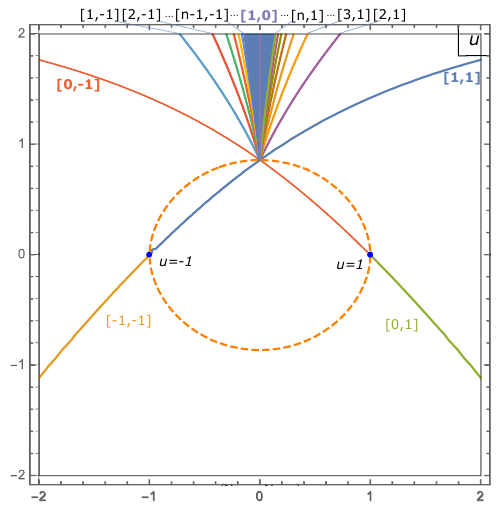
Figure 15 . The u plane for the pure SU(2) SYM theory with Λ = 1 . The wall of marginal stability is shown as an orange dashed curve passing through the magnetic and dyonic singularities at u = ± 1 . We plot arg( Z ( u, Λ = 1)) = π/ 4 for different γ . The notation [ i, j ] stands for a γ path obeying arg( Z ( u, Λ = 1)) = π/ 4 . In the strong coupling region we have only two paths γ [ i,j ] corresponding to arg( Z ( u, Λ = 1)) = π/ 4 and arg( Z ( u, Λ = 1)) = π/ 4 . Outside the wall of γ [0 , − 1] γ [1 , 1] marginal stability, there is a vector multiplet [1 , 0] and an infinite tower of hypermultiplets: [ n, − 1] and [ n + 1 , 1] with n ≥ 1 . These accumulate around [1 , 0] when n → ∞ . At the boundaries of this infinite tower we have [0 , − 1] and [1 , 1] .